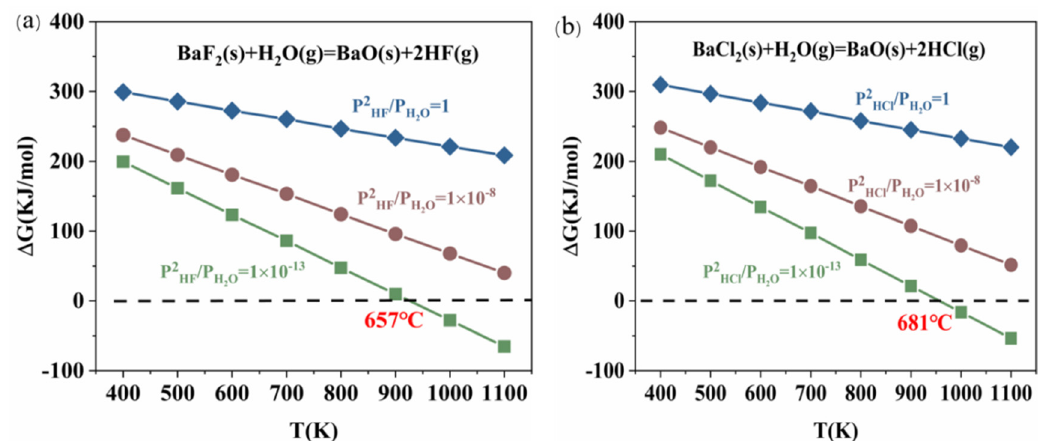
Figure 9. Gibbs free energy changes under different proportions of exhaust gas partial pressure and water pressure: ( a ) BaF 2 reacts with water vapor; ( b ) reaction of BaCl 2 with water vapor.